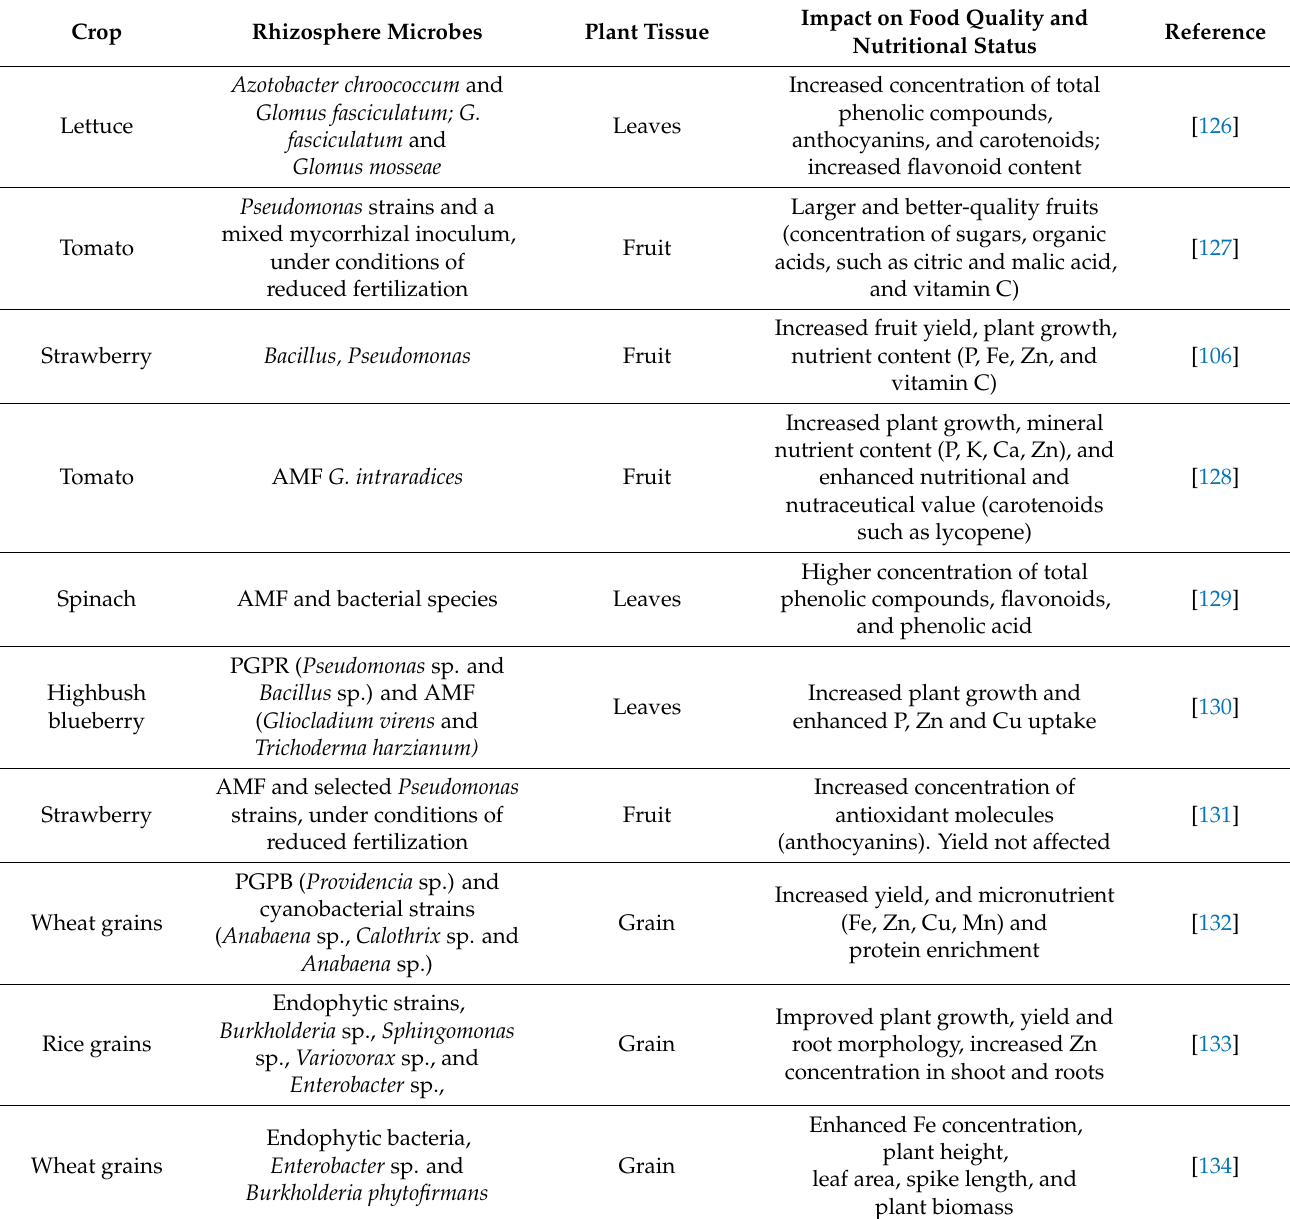
Table 2. Examples of studies showing the effect of rhizosphere microbes on food nutritional quality. Impact on Food Quality Rhizosphere Microbes Plant Tissue